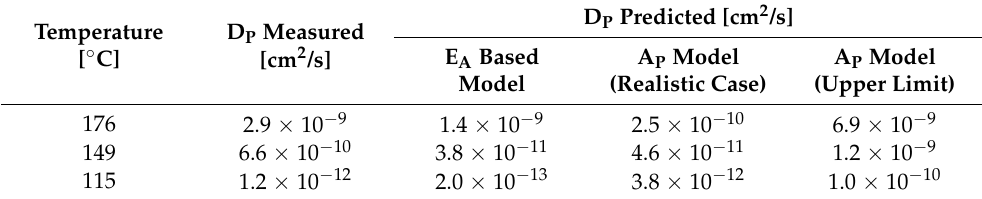
Comparison of reported experimentally determined diffusion coefficients (D P ) for C[TPA+EG]3 [5] and predicted values from the E A -based prediction model [14] and the A P model (realistic case and upper limit)